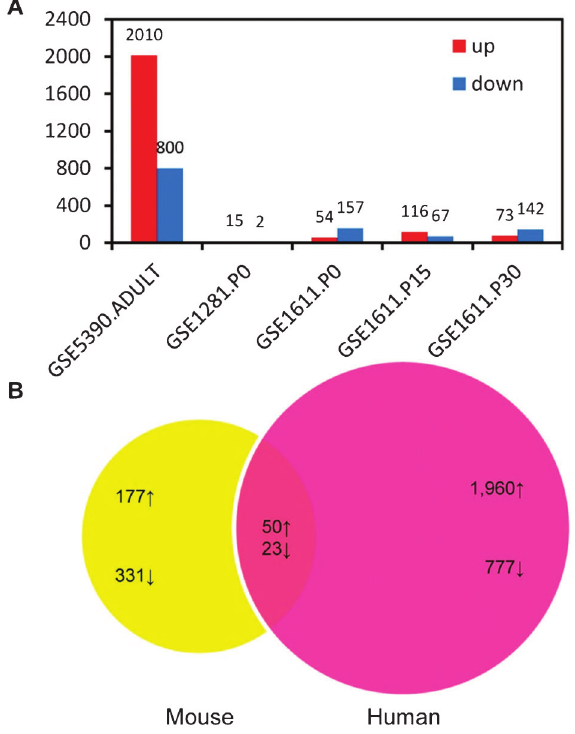
Figure 1. A , Differentially expressed genes (DEGs) in Down syndrome samples compared with normal samples. B , Venn diagram of DEGs in human and mouse. (Table 1). Molecular interactions of the following eight genes are shown in Figure 2B: CBR1 (carbonyl reductase 1), DYRK1A , HMGN1 , ITSN1 [intersectin 1 (SH3 domain protein)], RCAN1 , SON , TMEM50B (transmembrane pro- tein 50B), and TTC3 (tetratricopeptide repeat protein 3). Information on interactions was selected from the BIOGRID database (20), but TMEM50B had no interaction information.